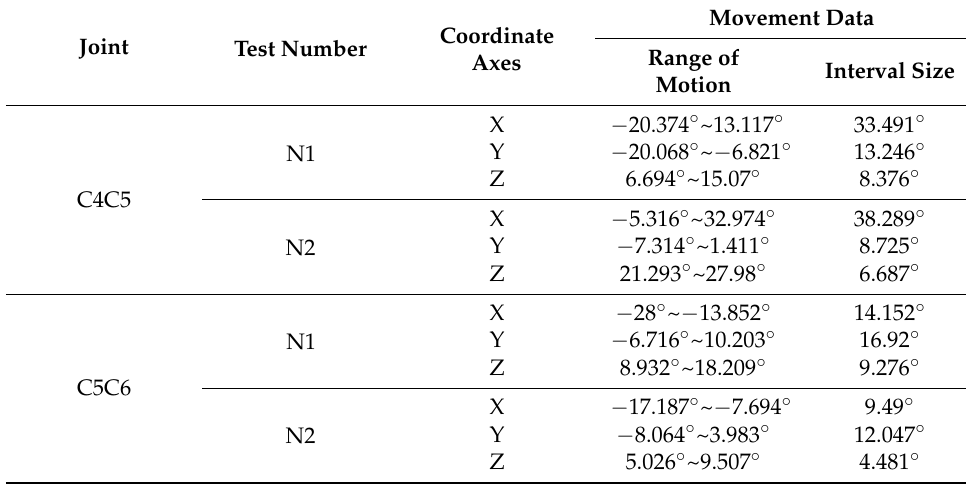
range around the X ‐ axis and the Y ‐ axis, and the Z ‐ axis was relatively less.